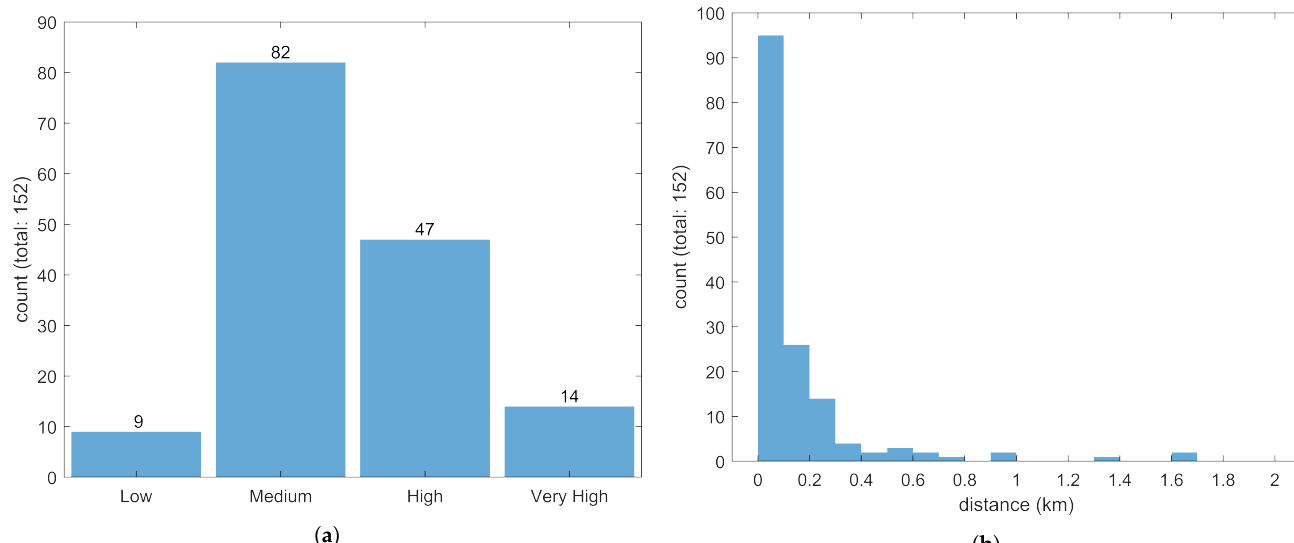
Figure 15. English Channel ( a ) AIS-SAR assignment confidence levels and ( b ) distribution of assignment